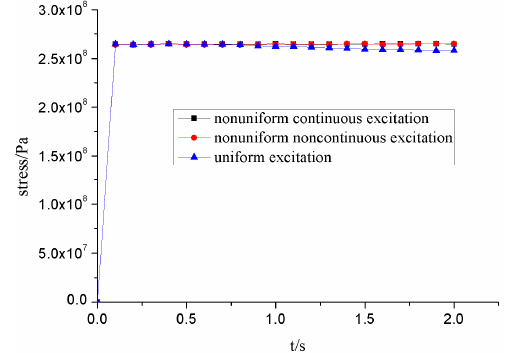
Figure 6. Comparison of stress at the end of the pipeline.